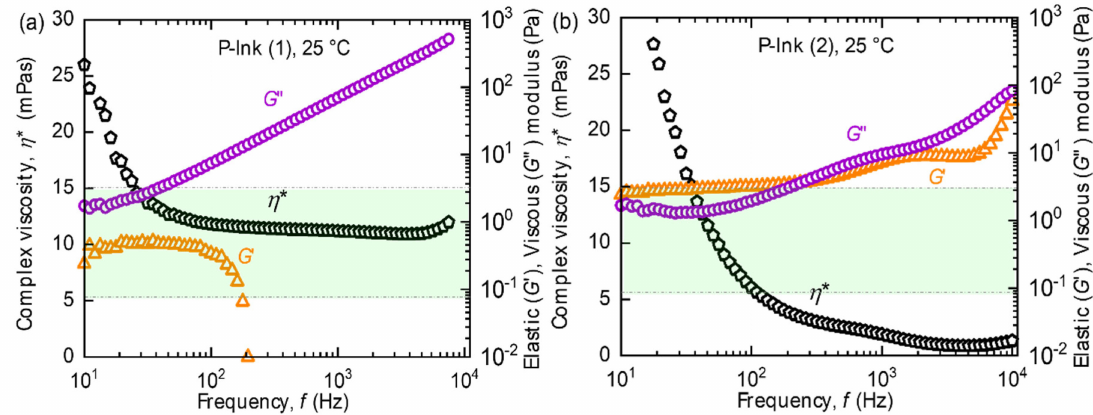
Figure 5. Flow curves show the complex viscosity ( η * ), elastic ( G (cid:48) ) and viscous ( G ”) modulus measurements of ( a ) P-ink (1), and ( b ) P-ink (2) with respect to frequency ( f ) measured with the PAV rheometer [16]. Rectangular boxes in light green shade represent the range of rheological properties favourable for inkjet